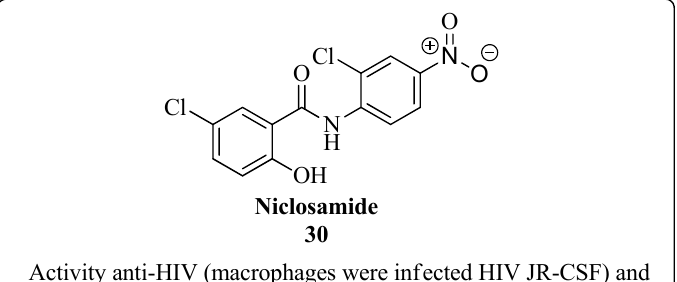
Figure 23. Niclosamide 30 is a potential dual anti-MTB and anti-HIV drug [74].